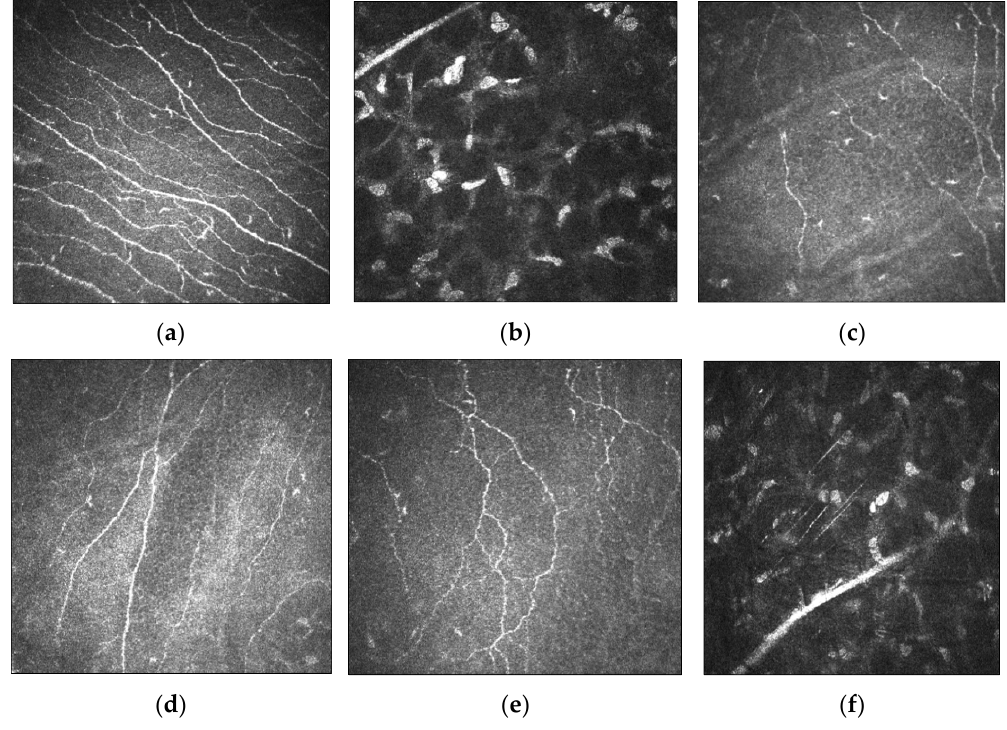
Figure 3. Morphology of corneal nerves evaluated by IVCM imaging in healthy and keratoconic corneas. ( a ) Subbasal nerve plexus with almost parallel nerve fibre bundles as observed in healthy corneas. ( b ) Normal stromal nerves in healthy corneas. ( c – e ) IVCM images demonstrate decreased nerve fibre density, thickened subbasal nerves and tortuous nerve paths in keratoconic corneas, respectively. ( f ) Thickened stromal nerves in keratoconic corneas. Scale bar: 100 µm.